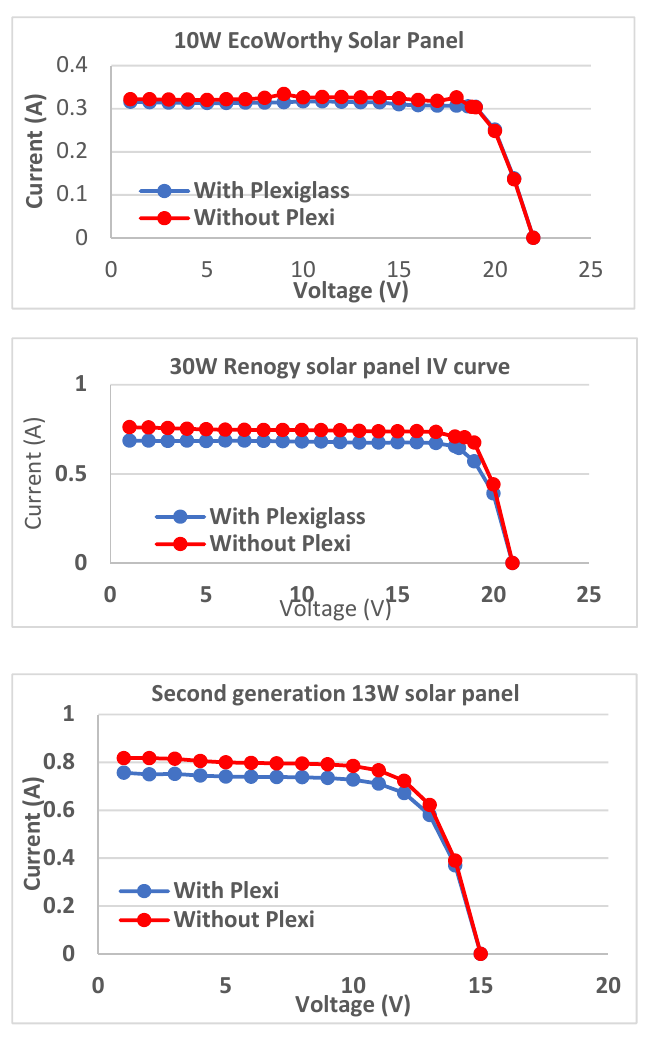
Figure 11. Testing the output power of the transparent plexiglass indoors with artificial light to determine the effects for the three solar panels.